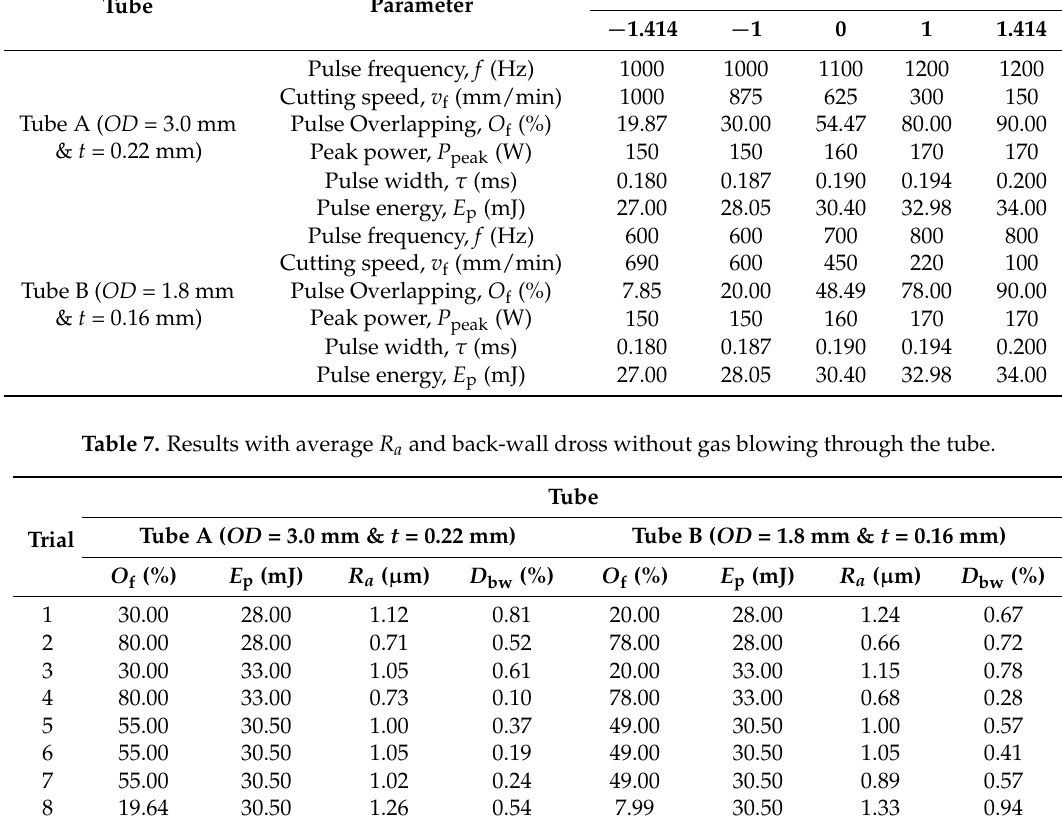
Table 6. Applied process parameters on a laser cutting machine without gas blowing through the tube. Tube Parameter